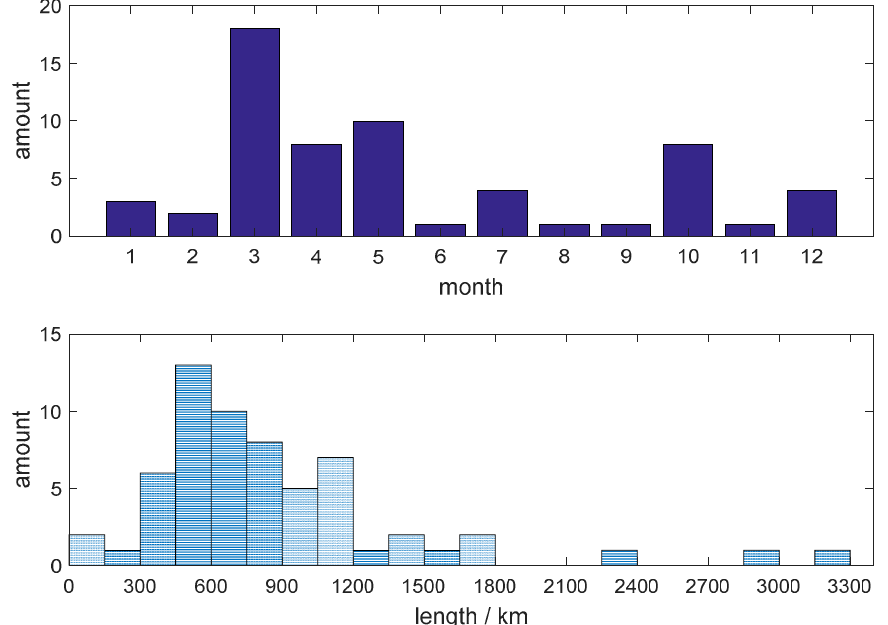
Figure 7. Mesospheric bore occurrence months ( top ) and the bore widths based on the 61 events ( bottom ).